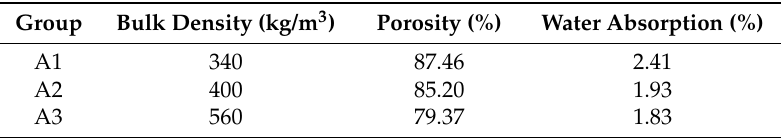
Table 3. Bulk density and porosity of TMFG. Group A: Specimens without microcrystalline decoration surface; Numbers 1–3: Three different batch compositions of the main raw